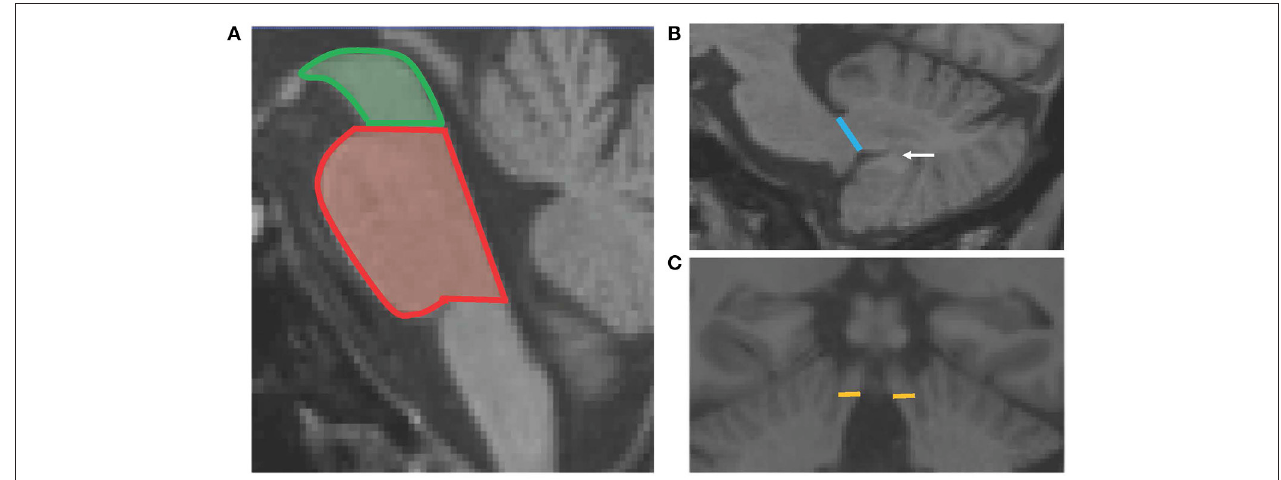
FIGURE 1 | Schematic diagram showing the four MRPI measurements. Panel (A) shows the horizontal lines of the superior pontine notch which divides the midbrain (green) and pons (red) cross-sectional areas. Panel (B) shows the line drawn to define the MCP width, which is the linear distance between the peripeduncular cerebrospinal fluid spaces of pontocerebellar cisterns. The white arrow points to the white matter connecting the cerebellar tonsil to the deep white matter of the cerebellum. Panel (C) shows the horizontal lines which delineate the SCP width, at the coronal slice where the SCP first separates from the inferior colliculi.